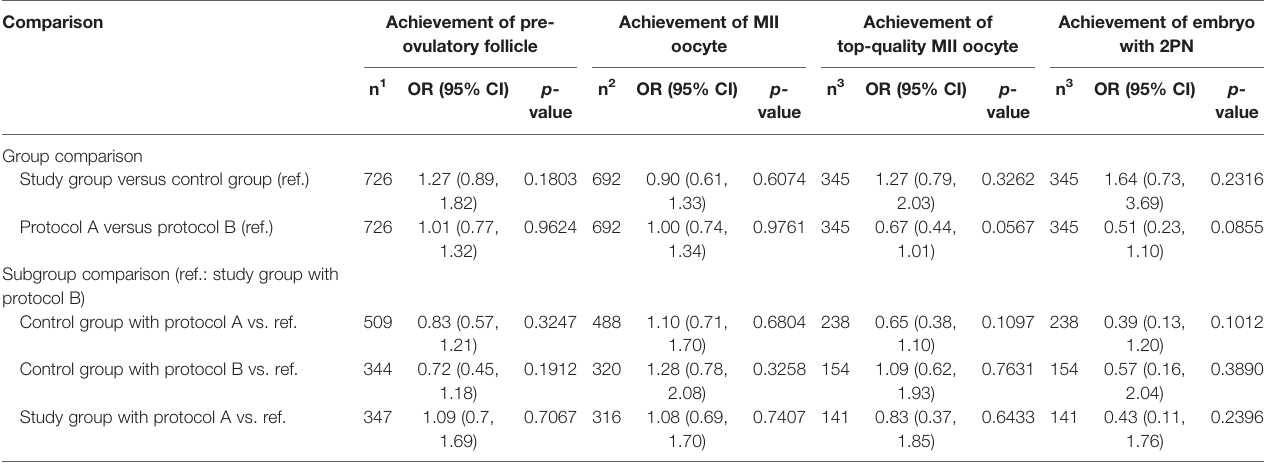
TABLE 3 | Results of embryo outcomes between treatment protocol groups obtained using multivariable generalized equation model analyses with adjusted repeated stimulation cycles for a given patient. Comparison